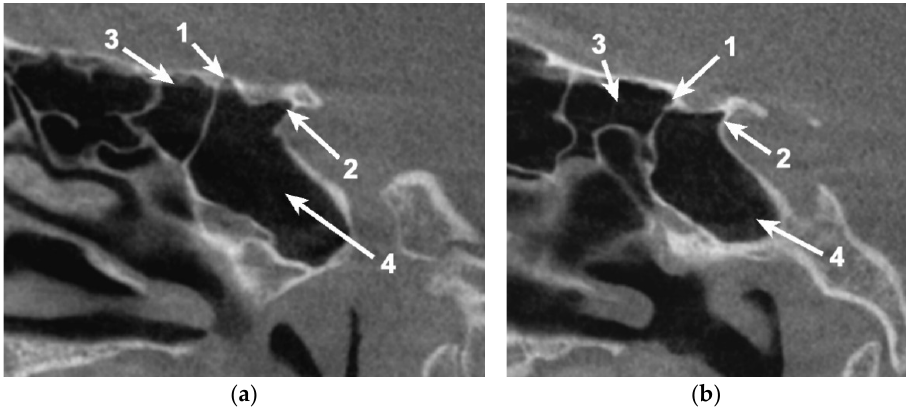
Figure 3. Bilateral sagittal CBCT reconstruction, demonstrating the pattern of pneumatization of both the optic strut (OS) and anterior root (AR). ( a ) Left side; ( b ) Right side: 1. Pneumatized AR; 2. Pneumatized OS; 3. Onodi cell; 4. Sphenoid sinus. Table 2. Origin and prevalence of the pneumatization from the paranasal sinuses in the optic strut (OS) and the anterior root (AR) of the lesser sphenoidal wing. ONC—Onodi cell. N = 43 sides.